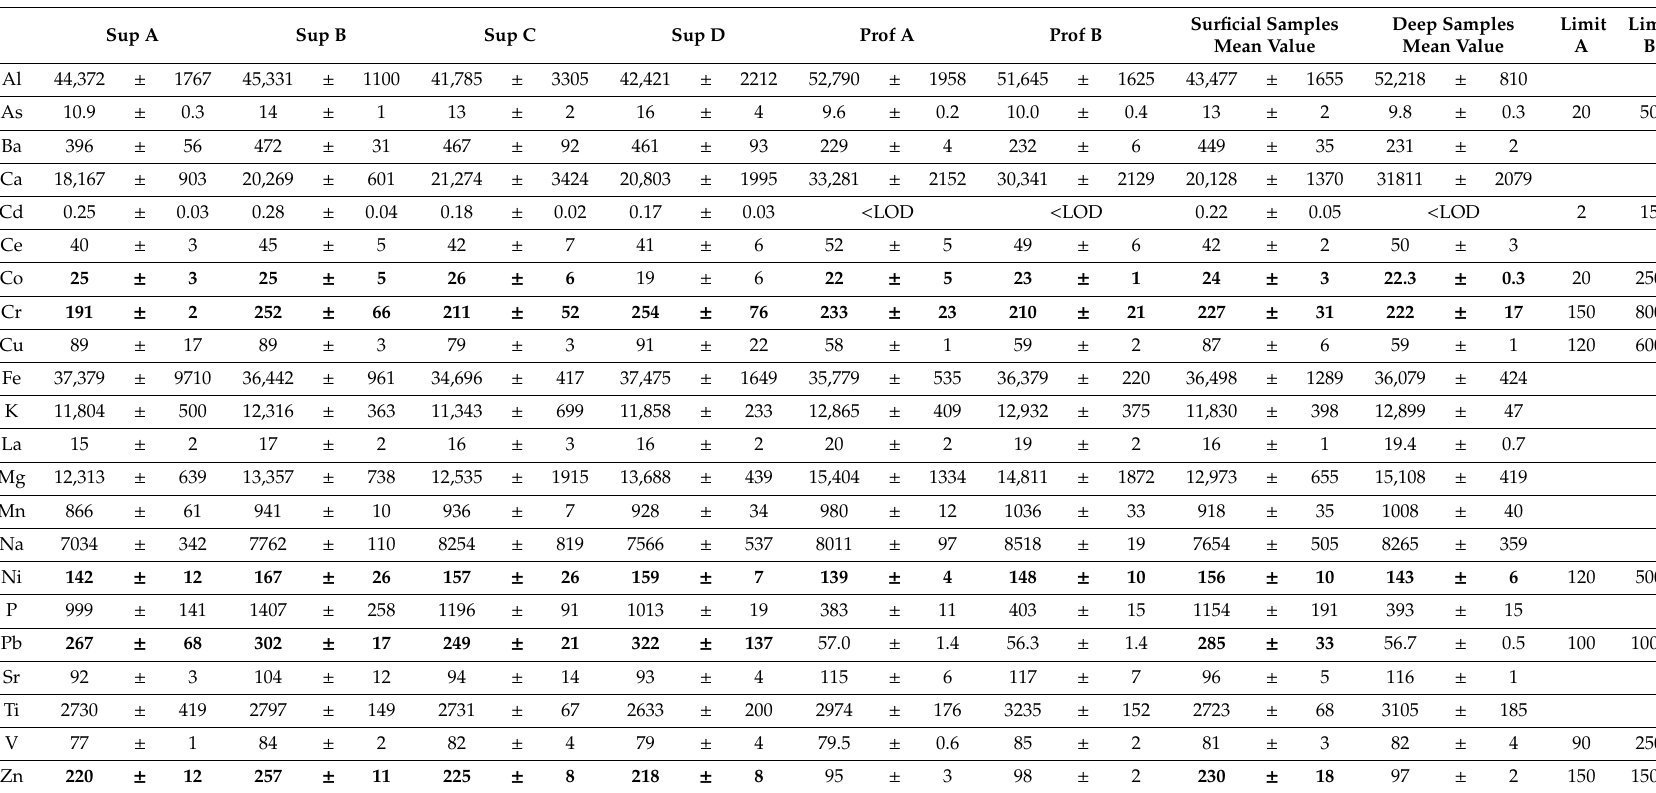
Table 3. Concentrations (mean and standard deviation) of the elements determined in the soil samples collected in the CA site and comparison with Italian legislation limits for green public areas (limit A) and industrial areas (limit B). All the concentrations are expressed as mg kg − 1 dry weight. < LOD indicates that the concentration of the element is below the limit of detection of the analytical technique. Element concentrations that exceed limits for green public areas are reported in